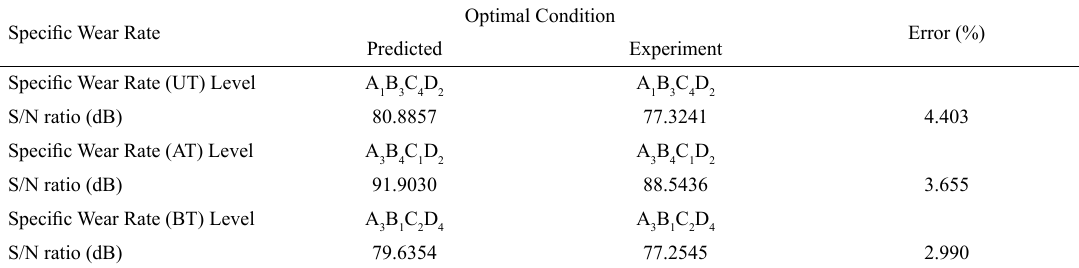
Table 4. Results of confirmation experiment Specific Wear Rate